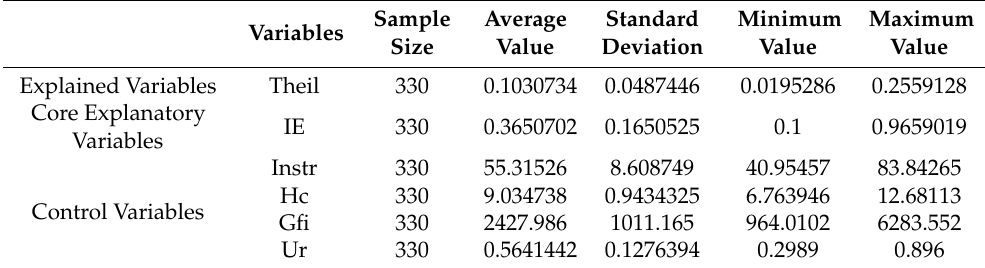
Table 2. Descriptive statistics of the